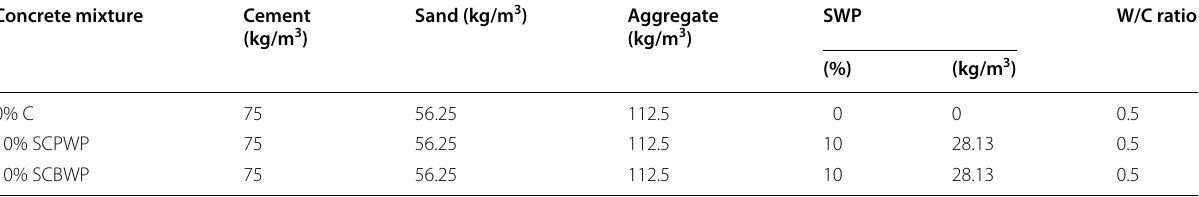
Table 4 Grade 30 proportion for RCB Concrete mixture